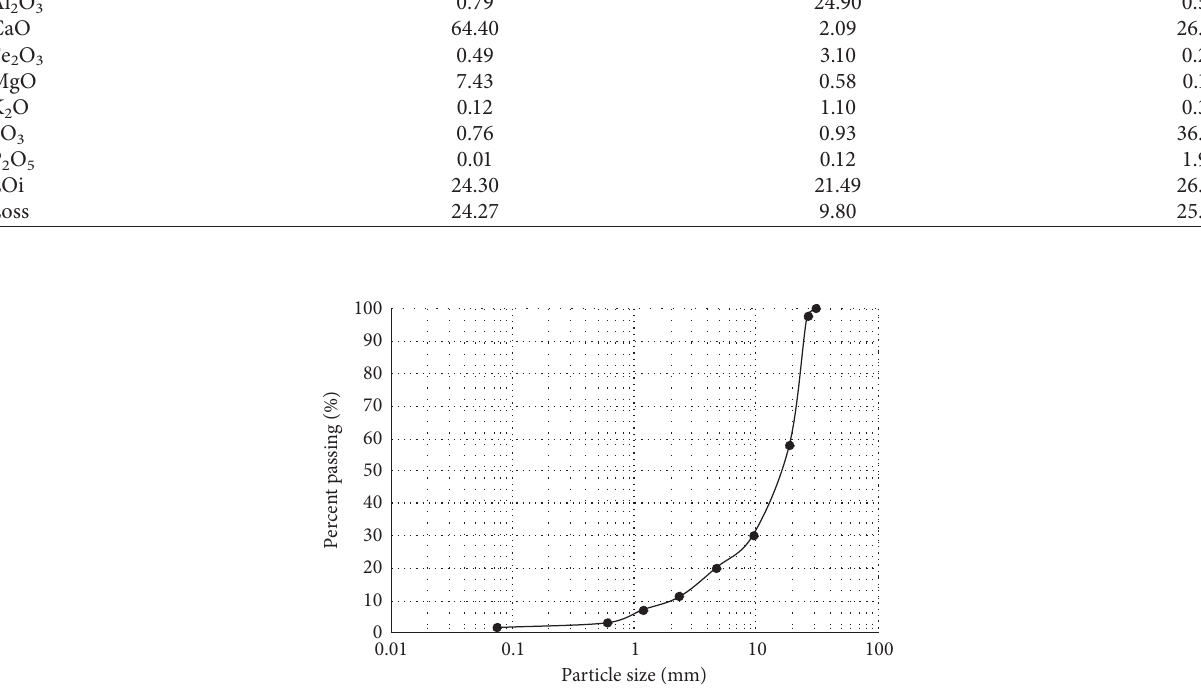
Figure 1: The particle-size distribution of